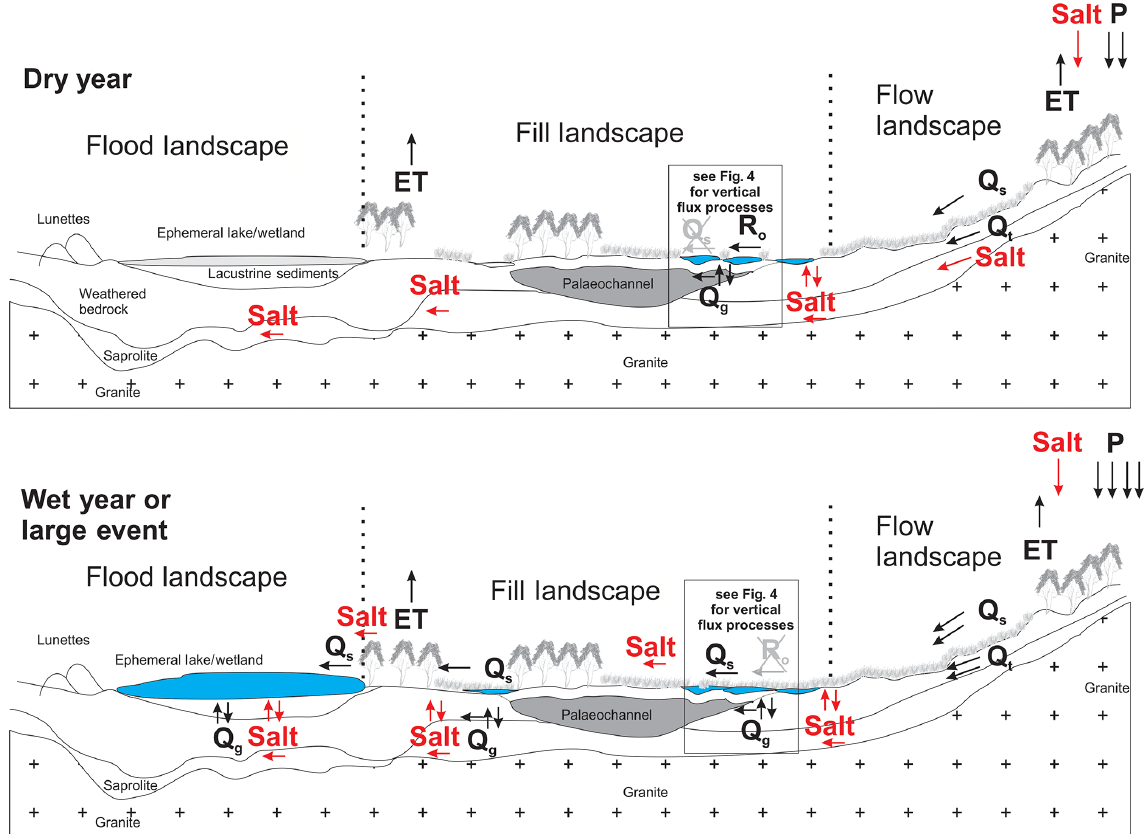
Figure 6. Flow–fill–flood conceptual model of surface water and salt flux in dryland catchments, showing disconnected flow during dry years and flow connection in wet years and large events that record flow at the end-of-catchment gauge. Hydrochemical fluxes are (water flux in black, salt flux in red): precipitation ( P ), evapotranspiration (ET), surface discharge or flow ( Q s ), throughflow ( Q t ), groundwater discharge or flow ( Q g ), and runon storage ( R 0 ). Salt fluxes are shown in red and show how salt is moved, concentrated and then moved down